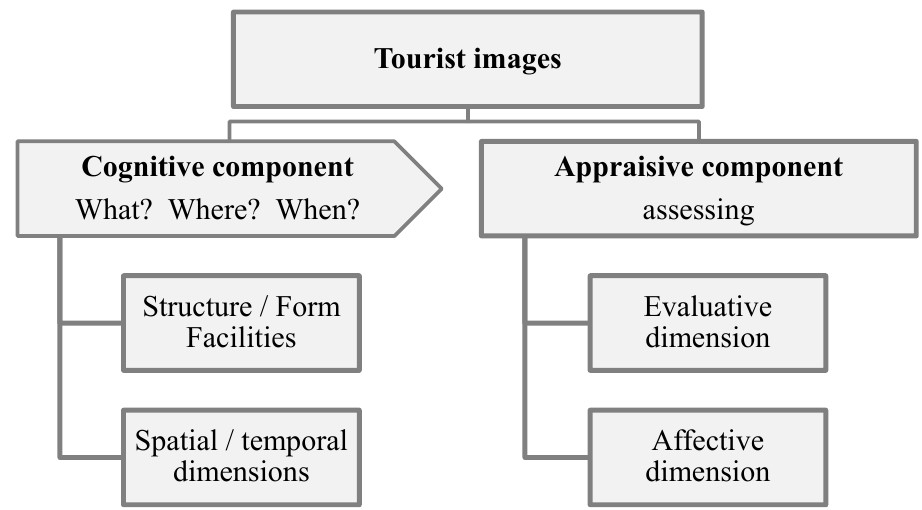
Figure 1. Destination image components. Source: Authors, derived from Marine-Roig [31].